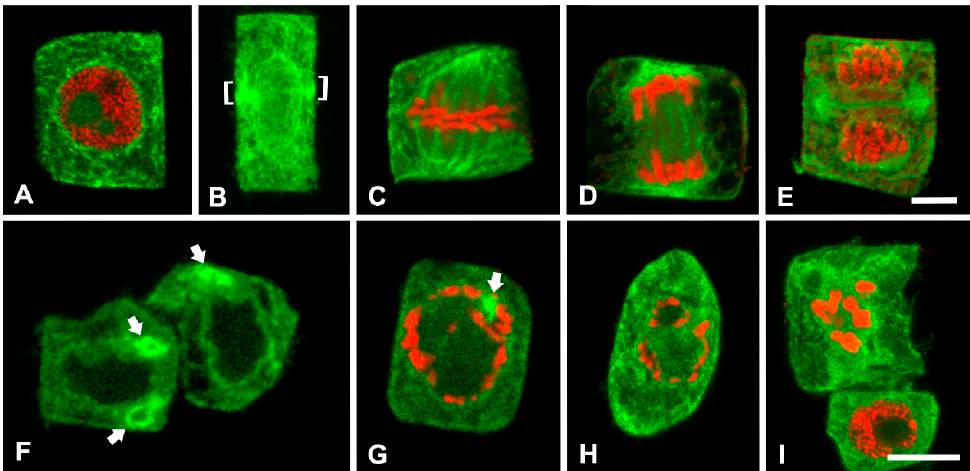
Figure 6. Confocal laser scanning microscopy (CLSM) images of ER (green) and DNA fluorescent staining (red) in P. sativum cortex cells of the meristematic zone. Single CLSM sections, except for B which is a projection. Upper row: control; lower row: 200 mg/L W-treated, 24 h. ( Α ) . Interphase cell. The ER is distributed evenly throughout the cytoplasm, while the nuclear envelope is also labeled.